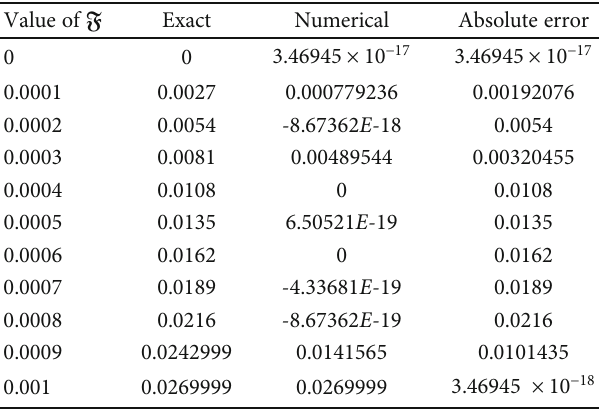
Table 3: Exact and numerical value of the Atangana conformable derivative ( 1 + 3 )-ZK equation with power-law nonlinearity through the obtained analytical solutions via the modi fi ed Khater method Equation (20) and septic B-spline